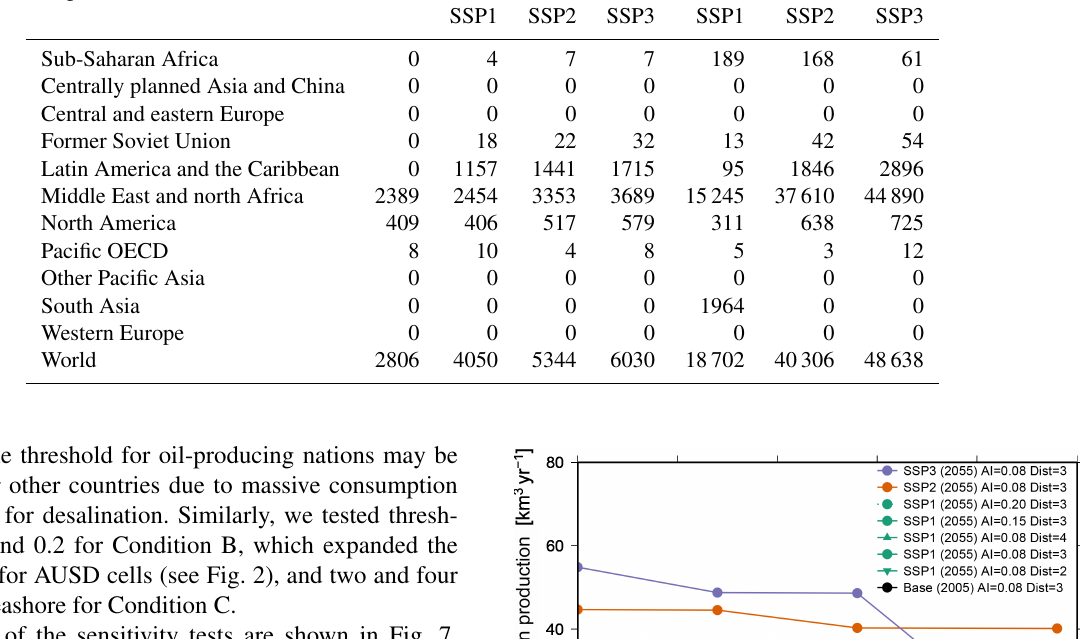
Table 5. Production of desalinated water by region (10 6 m 3 yr − 1 ). See Table S4 for classification of countries. Region